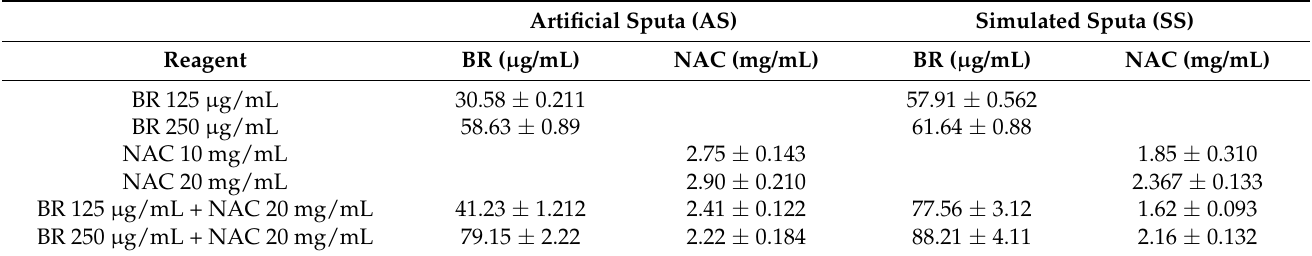
Table 5. The concentration of either bromelain (BR) or acetylcysteine (NAC) in two sputa models (AS and SS) after passage of nebulized solution over the sputa with just bromelain, just NAC, or their combination, over 25